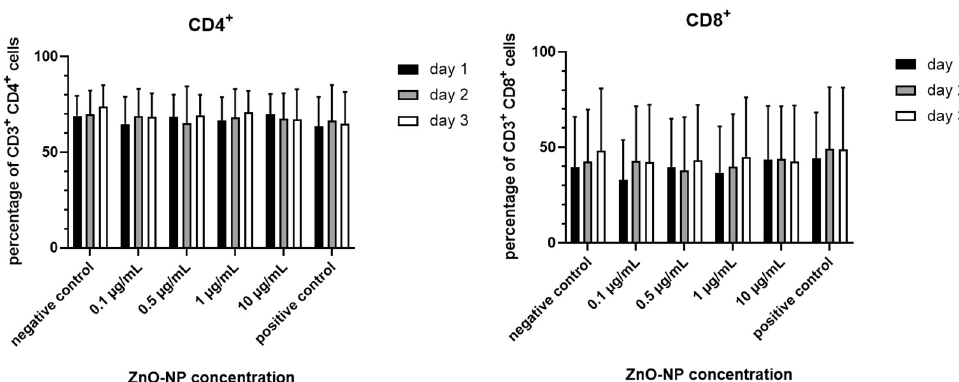
Figure 3. Ratio of CD8 + and CD4 + T cells after incubation with ZnO-NP in different concentrations for 24, 48, or 72 h. Changes were not statistically significant compared to the negative control. Data represent the mean +/ − standard deviation (n = 9 for day 1 and 2, n = 7 for day 3 for CD4 + cells; n = 7 for day 1, n = 6 for day 2 and 3 for CD 8 + cells).